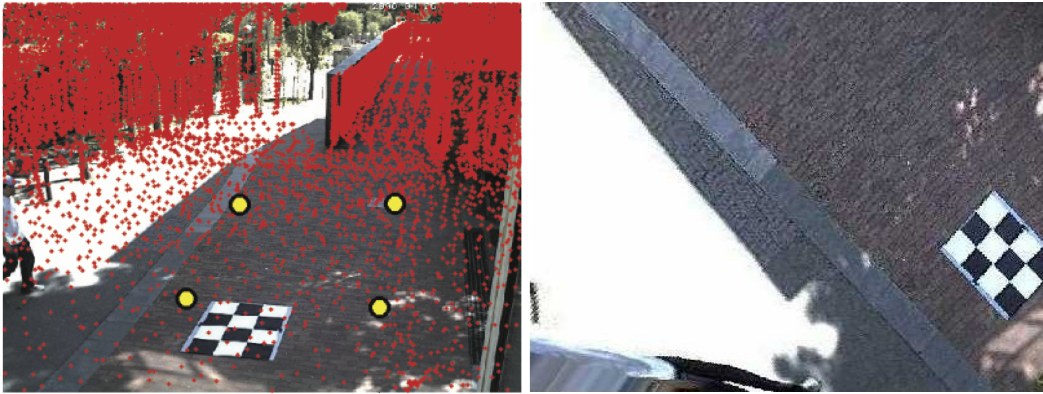
Figure 1. Results of the proposed calibration system. ( Left ) Plane selection in a graphical user interface and registration of the laser range data with a view from one of the cameras in the network; ( Right ) recovered orthographic view of the ground plane. The chess pattern shown is not used for calibration; it serves just to visually evaluate the quality of the ground-plane rectifying